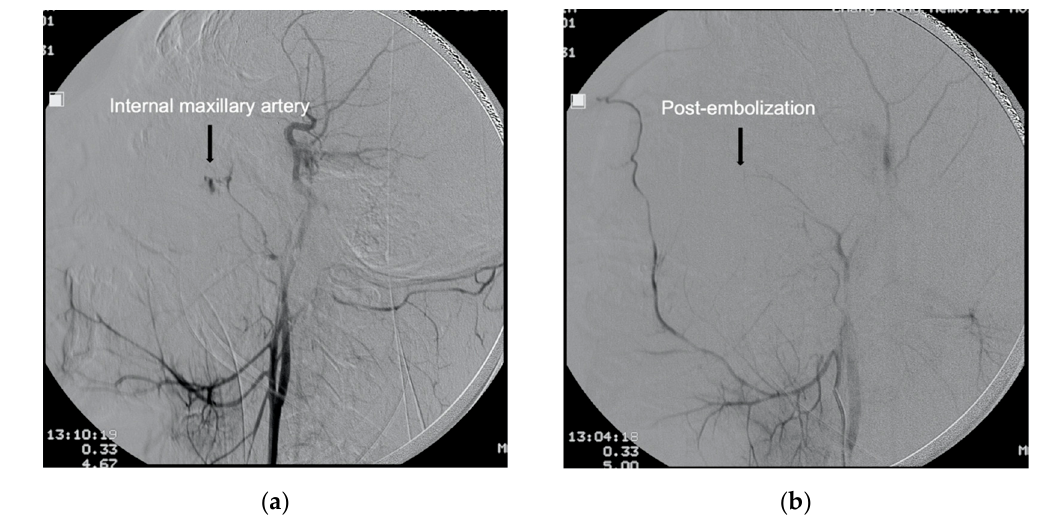
Figure 3. Angiogram of the patient shown in Figure 2. ( a ) Lateral angiogram of common carotid artery shows contrast extravasation from internal maxillary artery (arrow). ( b ) Post gelatin foam embolization images showing hemostasis (arrow).